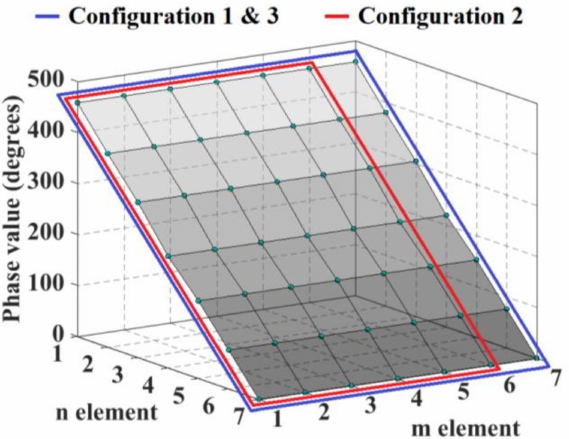
Figure 3. Phase plane generated for each design configuration of 2-D phased